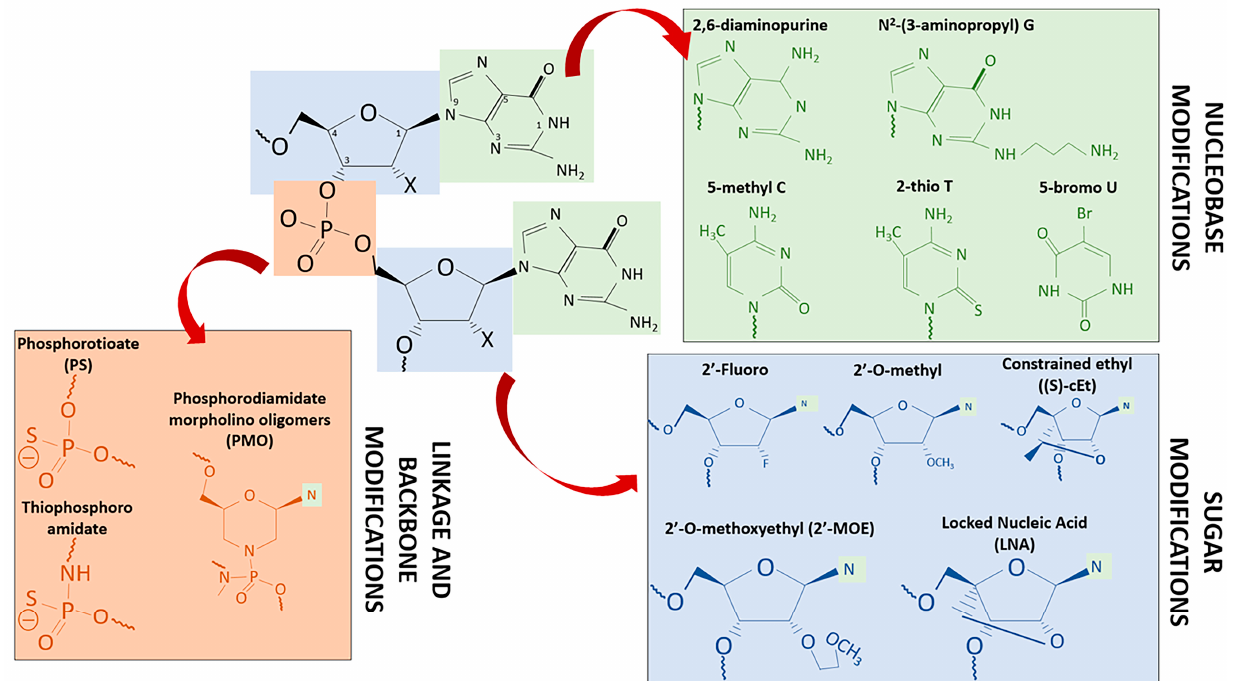
Figure 2. ASO chemical modifications. Key chemical modifications of ASOs are site-specific, based on the structure, as shown in this example of an RNA molecule with dinucleotide purines, linkage, and sugar numbering, where X could be H (for DNA) or OH (for RNA). Relevant modifications from each group used in clinical trials and commercialized drugs are shown with their corresponding color (green for nucleobase modifications, blue for sugar modifications, orange for phosphodiester linkage modifications, “N” with green halos correspond to simplified nucleobases). Modification improvements are listed on Table 1.